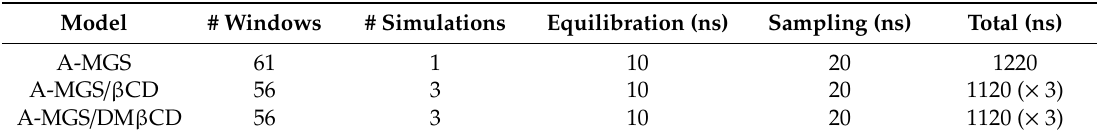
Supplementary Materials: The following are available online. Figure S1: Penetration of MGS into interior membrane of lipid bilayer, Figure S2: The last MD snapshots for the MGS adsorption on lipid bilayer, Figure S3: Time evolution of number of H-bonds, Figure S4: The last snapshots for the inclusion complexes adsorption on lipid bilayer for A-MGS / CD, Figure S5: The last snapshots for the inclusion complexes adsorption on lipid bilayer for C-MGS / CD, Figure S6: The PMF profile for MGS penetration through the POPC membrane, Figure S7: Triplicate PMF profiles.